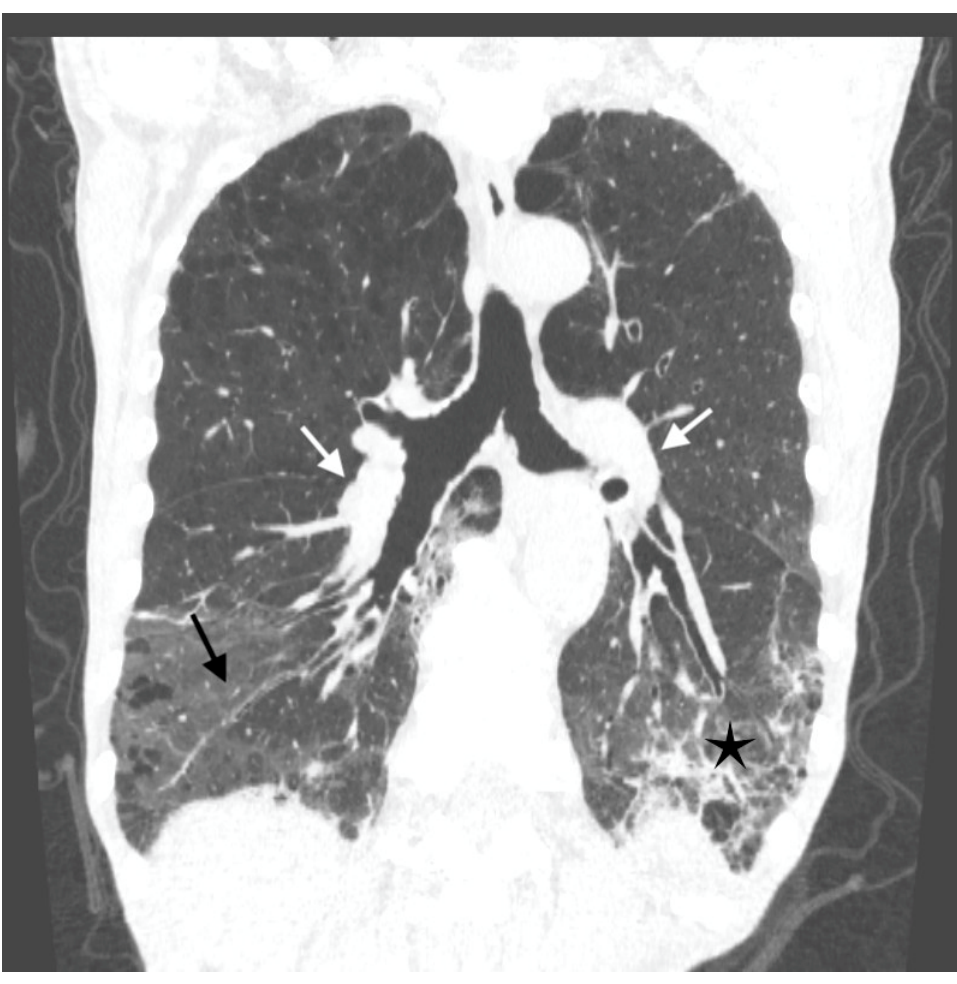
Figure 5. CT-scan of the chest after 3 weeks of anti-tuberculous treatment showing partial resolution of ground glass opacities (black arrow) and parenchymal infiltrates (asterisk), and decreased lymphadenopathy (white arrows).